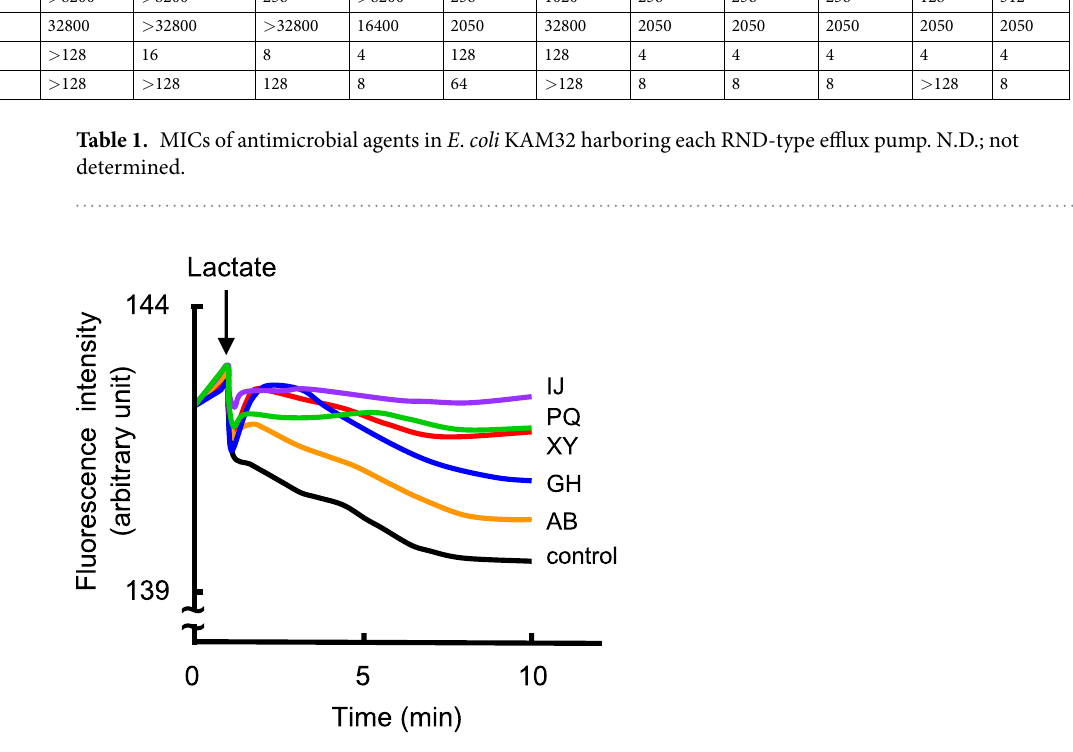
Figure 3. Rhodamine 6 G efflux assay. Energy-starved cells of E . coli KAM32 strains that express S . marcescens RND efflux systems were prepared as described in the Materials and Methods. Energy-starved cells